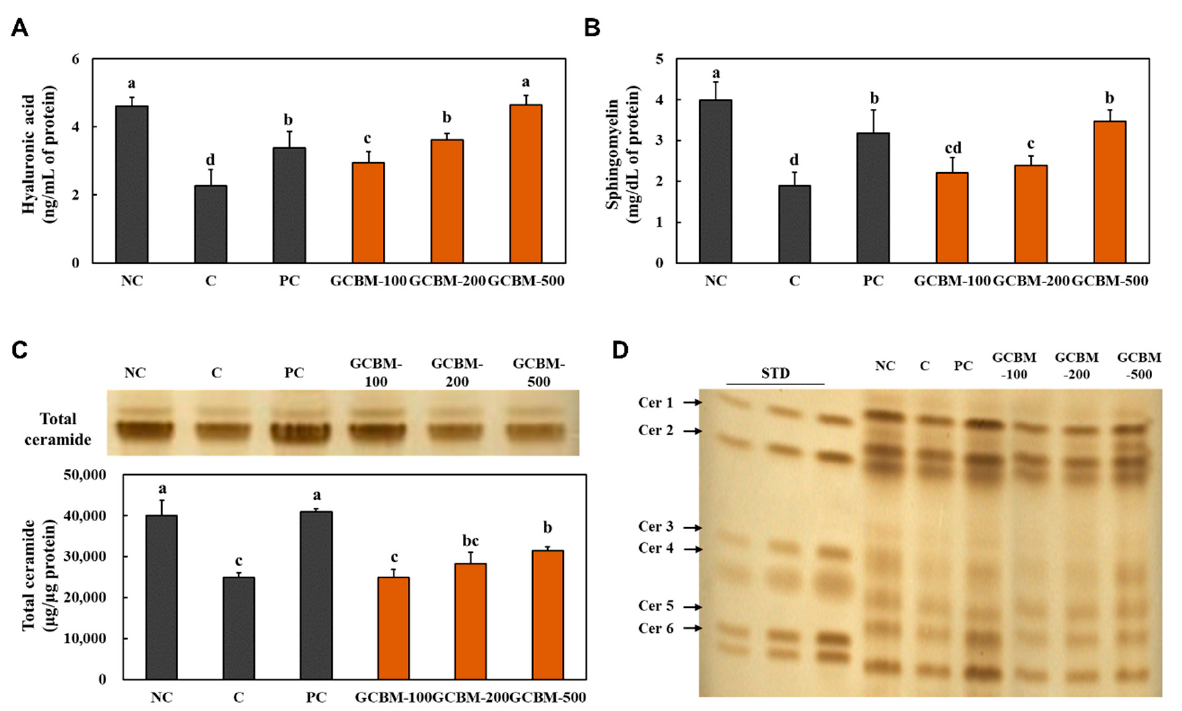
Figure 4. Effects of GCBM on the levels of hyaluronic acid ( A ), sphingomyelin ( B ), total ceramide ( C ), and the contents of ceramide 1~6 ( D ) in the dorsal skin of UVB irradiation-induced photoaging in mice. Normal control (NC), control (C; UVB-irradiation), positive control (PC; UVB-irradiation with diet containing L -ascorbic acid at 100 mg/kg/body weight [b.w.]), GCBM-100 (UVB-irradiation with dietary supplementation of GCBM at 100 mg/kg/b.w.), GCBM-200 (UVB-irradiation with dietary supplementation of GCBM at 200 mg/kg/b.w.), and GCBM-500 (UVB-irradiation with dietary supplementation of GCBM at 500 mg/kg/b.w.). Values are presented as mean ± SD. Different letters (a > b > c > d) indicate a significant difference, with p < 0.05, as determined with Duncan’s multiple range test.